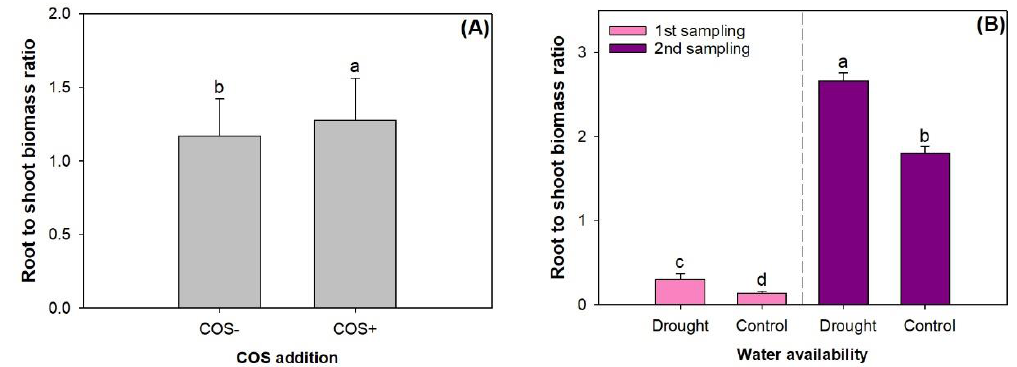
Figure 3. Root-to-shoot biomass ratio in Buddhist pine ( Podocarpus macrophyllus ) seedlings exposed to chitosan oligosaccharide (COS) addition (COS- vs. COS+) ( A ) and contrasting water availabilities (drought vs. irrigated control) in two samplings ( B ). Different letters indicate a significant difference according to Tukey’s test at the 0.05 level. Error bars stand for standard errors.